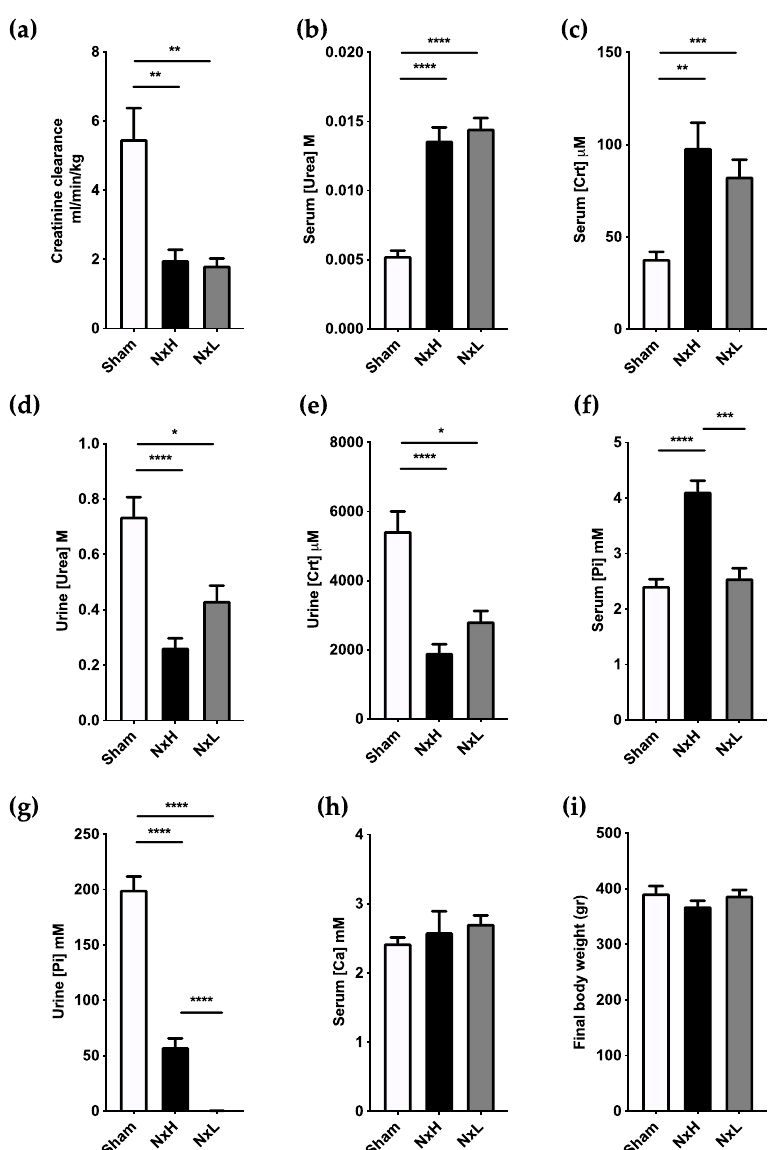
Figure 1. Development of renal failure in Chronic Kidney Disease (CKD) rats. ( a ); Creatinine clearance, ( b ); Serum ( Urea), ( c) ; Serum Creatinine ( Crt), ( d ); Urine (Urea), ( e ); Urine ( Crt), ( f ); Serum